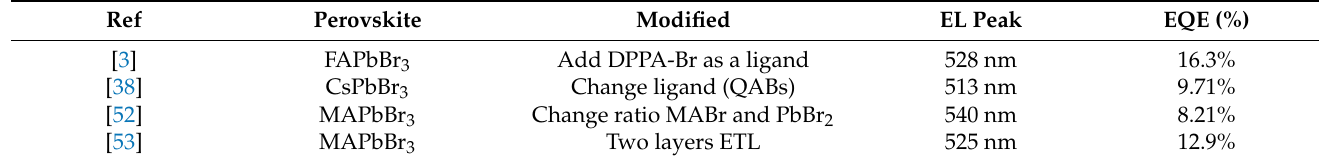
Table 3. Component parameter arrangement in the green light